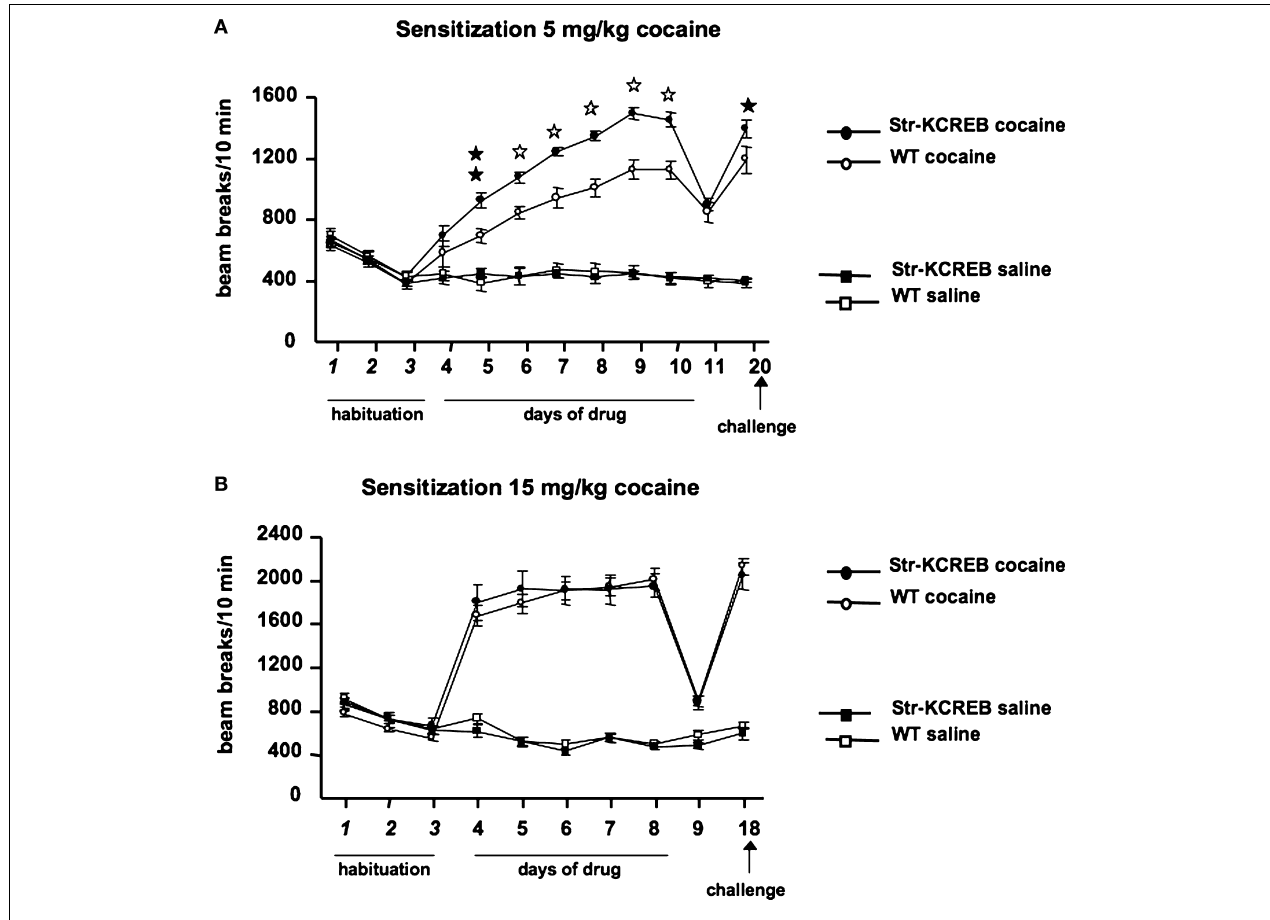
FIGURE 8 | Enhanced locomotor sensitization induced by cocaine in str-KCREB mice. (A) str-KCREB mice showed enhanced locomotor sensitization to 5 mg/kg cocaine. After 3 days of habituation, str-KCREB mice show increased locomotor sensitization across 7 days of cocaine ( n = 16 transgenic, 18 control) or saline ( n = 12 transgenic, 15 control;